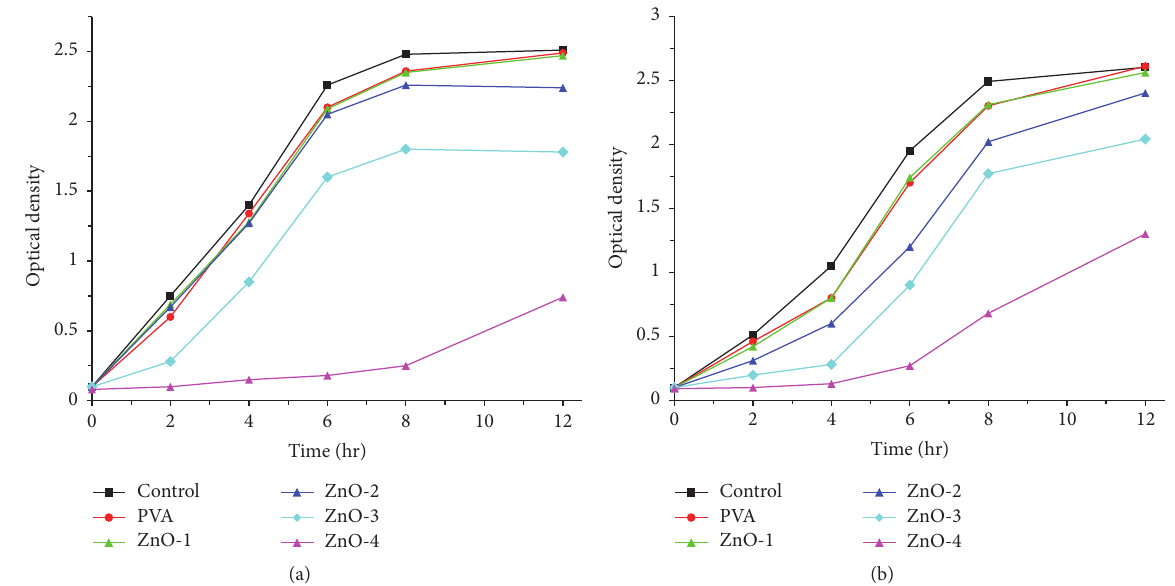
Figure 4: Effect of ZnO-PVA nanofibrous membranes on inhibition of bacterial cell growth. (a) S. aureus and (b) E. coli . Cell growth was monitored by measuring optical density at 600 nm.